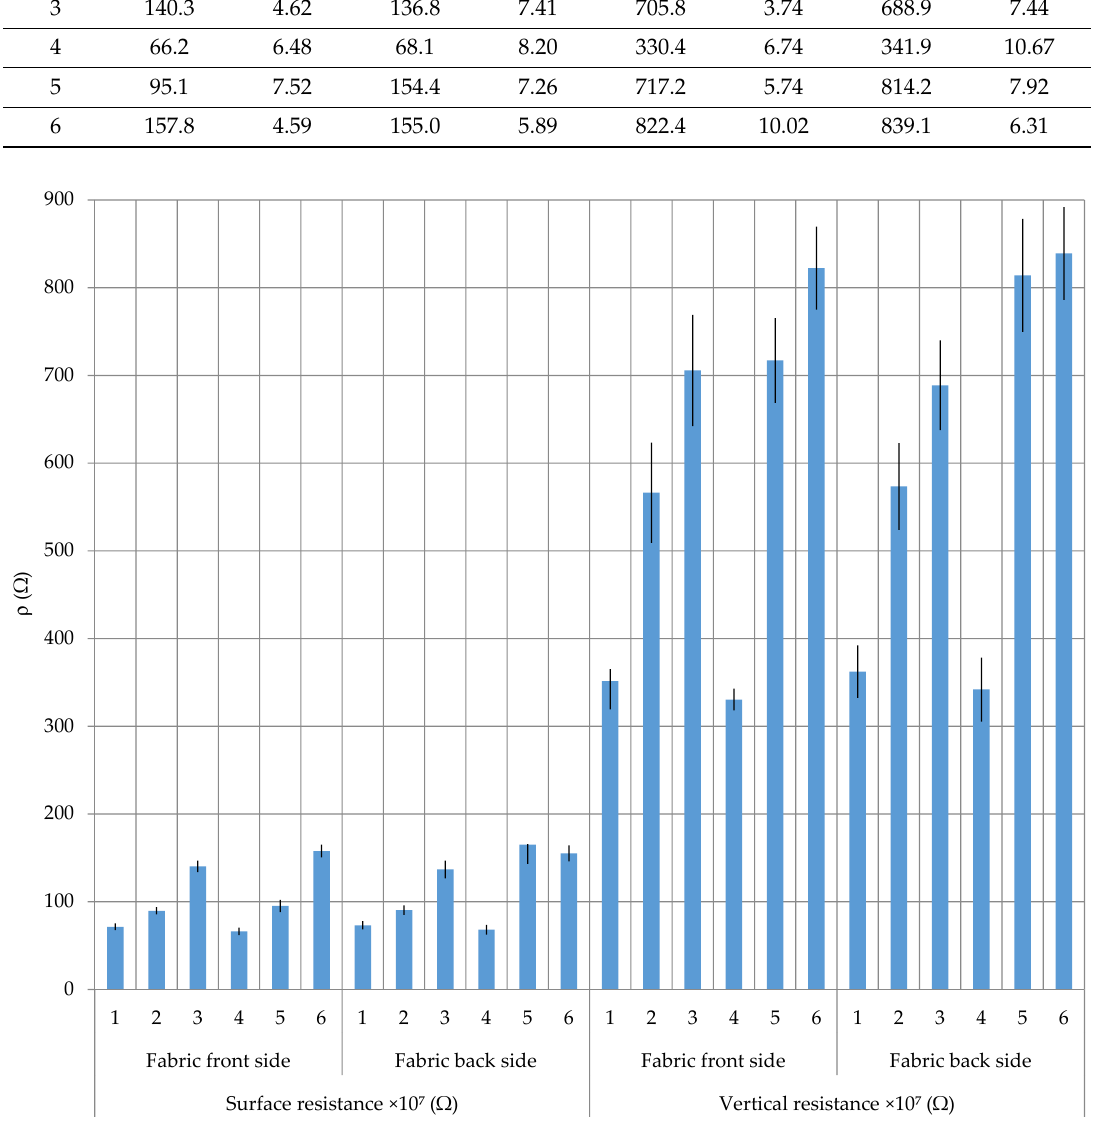
Figure 7. Surface and vertical resistance of the woven fabrics from the front to the back side, with error display.